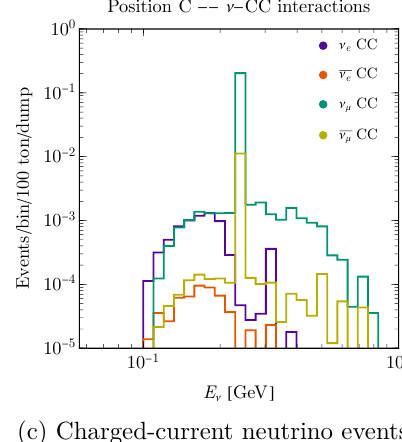
Figure 6. Event spectra for different interaction types from the low-energy neutrino flux at Position C. The different event types we display are CE ν NS ((b)); neutrino-Argon interactions ((a)) where the lines correspond to ν e Ar (dark blue), ν e Ar (light blue), ν Ar Neutral Current (orange); and the four possible charged-current quasi-elastic processes ((c)) with the lines corresponding to ν e (purple), ν e (orange), ν µ (green), and ν µ (dark yellow). All event rates are calculated per LHC beam dump and assume a detector volume of 100 ton (1 ton) for ν -Ar and ν -CC (CE ν NS)